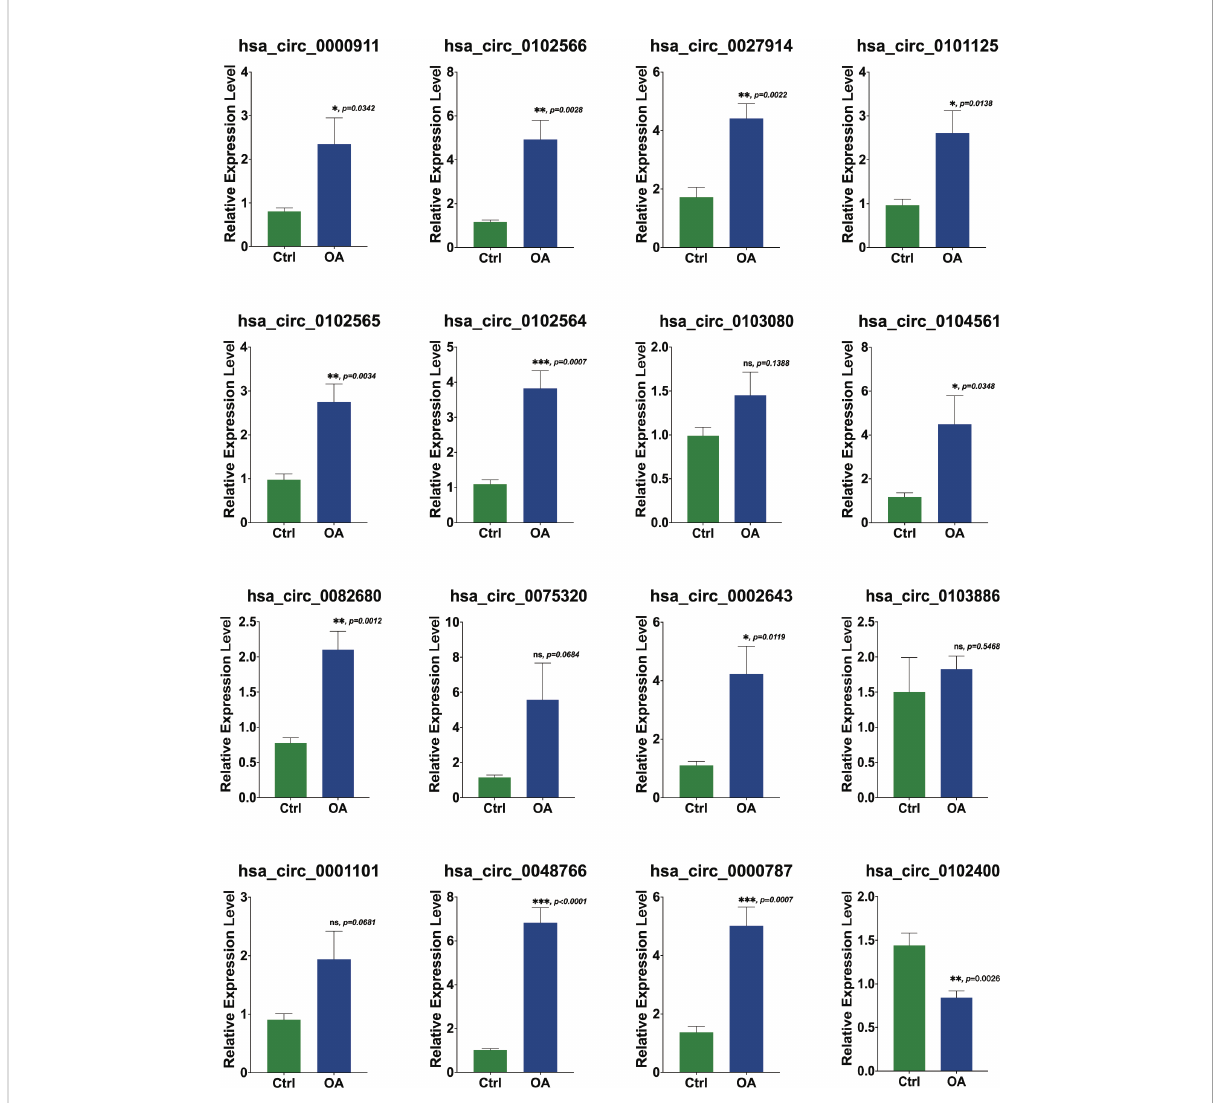
FIGURE 8 Validation of the expression of 16 DECs using RT-PCR. The relative expression levels of hsa_circ_00009, hsa_circ_0102566, hsa_circ_0027914, hsa_circ_0101125, hsa_circ_0102565, hsa_circ_0102564, hsa_circ_0104561, hsa_circ_0082680, hsa_circ_0002643, hsa_circ_0000787, and hsa_circ_0048766 were upregulated in OA cartilage, while the expression levels of hsa_circ_0103080, hsa_circ_0075320, hsa_circ_0001101, and hsa_circ_0103886 were not statistically signi fi cantly different. The relative expression level of hsa_circ_0102400 was obviously downregulated. Statistical difference: ***p < 0.001 ; **p < 0.01; *p < 0.05; ns , p >